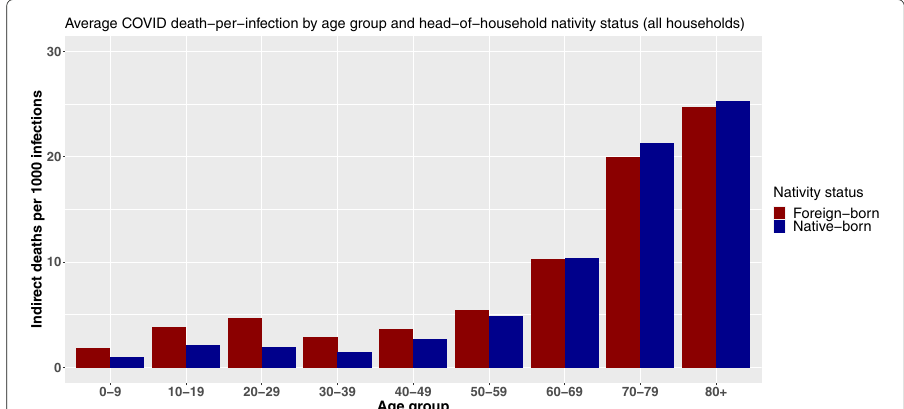
Fig. 4 Average COVID-19 indirect deaths per 1000 infections by age group and head-of-household nativity